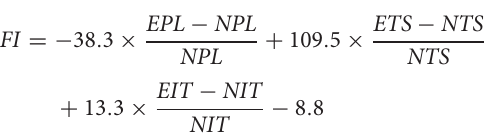
into 10-mm length and was sterilized by Zhao et al. (2020) Co for further